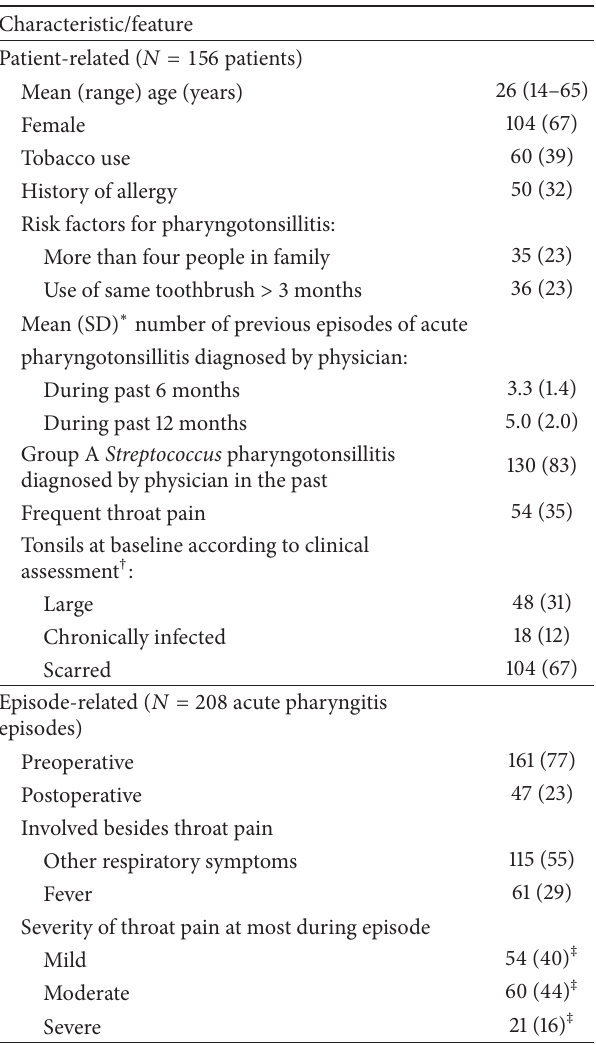
Table 1: Demographic and baseline characteristics of adult patients with recurrent pharyngotonsillitis and features of pharyngotonsil- litis episodes during follow-up (mean of 5.9 (SD 1.2) ∗ months). Figures are numbers (percentages) unless otherwise